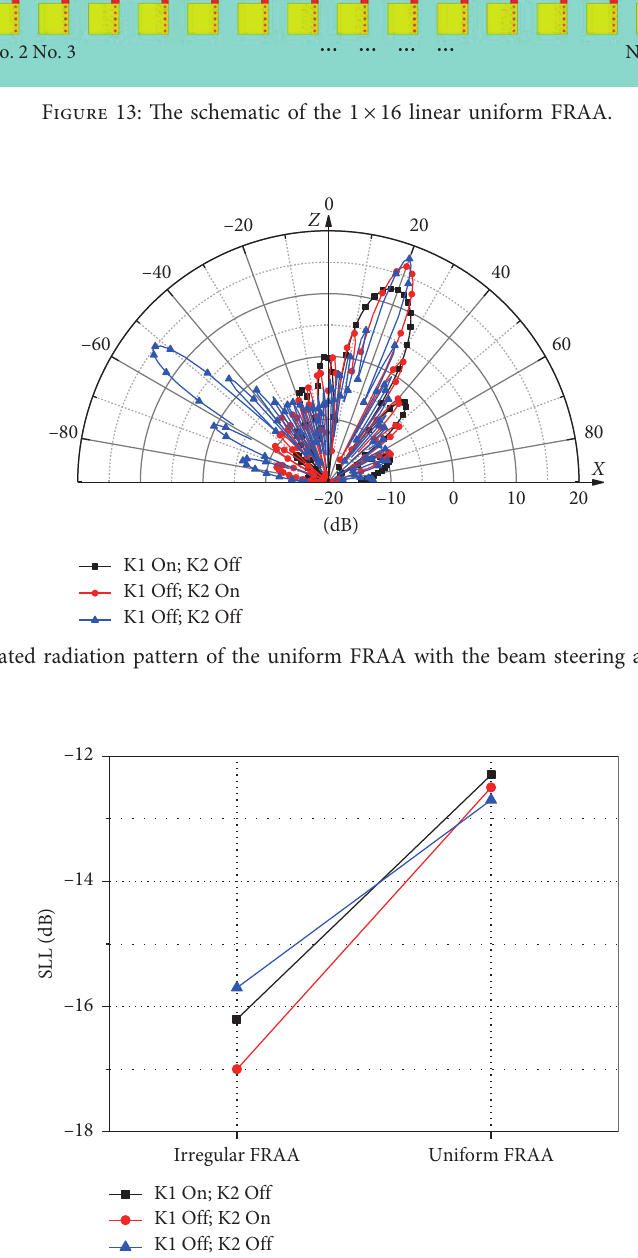
Figure 15: Comparison of sidelobe levels in irregular and uniform